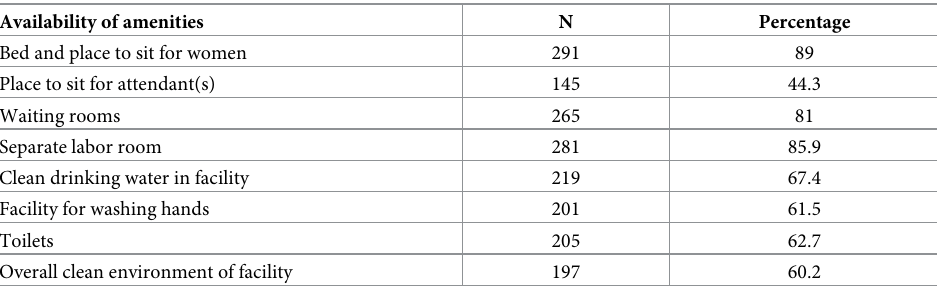
Table 3. Availability of amenities at health facilities.